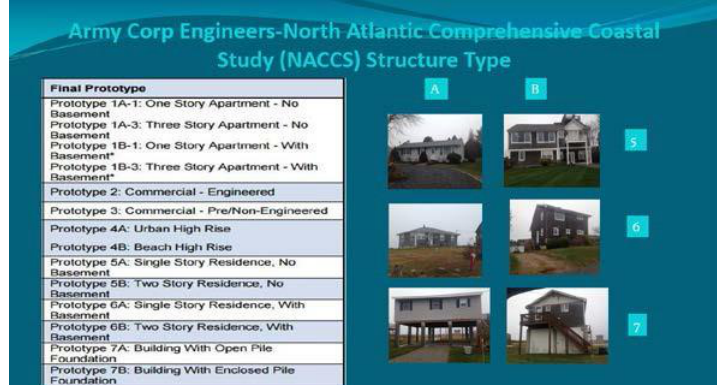
Figure 4. Army Corp of Engineers (ACOE) North Atlantic Coast Comprehensive Study (NACCS) structure types (left side). Photographs of structure prototypes 5, 6, and 7, categories A and B are also shown (right side). 5 and 6 are residences, without and with basements; while A and B refer to single and two story buildings, respectively. Prototype 7 have pile foundations, A—open piles and B— enclosed pile. Reproduced from [1], with permission from MDPI, 2020.